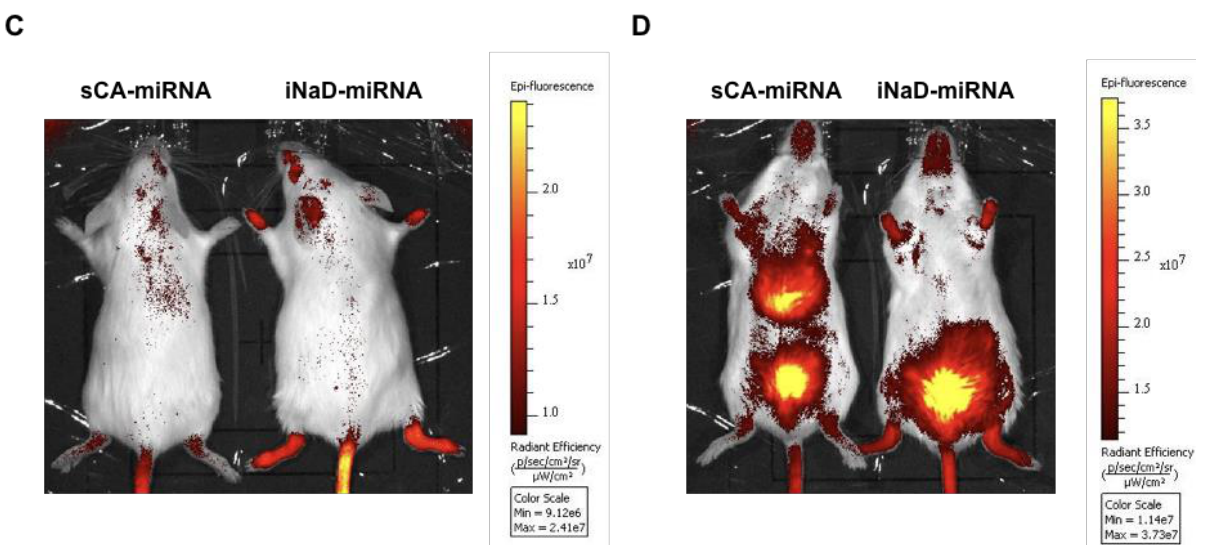
Figure 7. Bio-distribution in rheumatoid arthritis mice. ( A ) Female SKG/Jcl mice aged 8 weeks were given intraperitoneal injections (20 mg) of mannan suspended in 500 mL saline. Joint swelling was monitored by inspection and scored as 0 (no joint swelling), 0.5 (mild swelling of the ankle), or 1.0 (severe swelling of the ankle). ( B ) sCA-miRNA (loading: 24 µ g of Alexa Fluor 750-labeled miRNA/injection) or iNaD-miRNA (loading: 3 µ g of Alexa Fluor 750-labeled miRNA/injection) was intravenously administered into the tail tips of high arthritis score RA mice (severe swelling of the left and right ankles, RA score = 1 + 1). ( C , D ) IVIS imaging 40 min after the injection (C: back, D: abdomen). Left: sCA-miRNA-injected mouse. Right: iNaD-miRNA-injected mouse. Fluorescence from the miRNA accumulated in the liver of sCA-miRNA mice and was noted in the urine (bladder) of both mice.